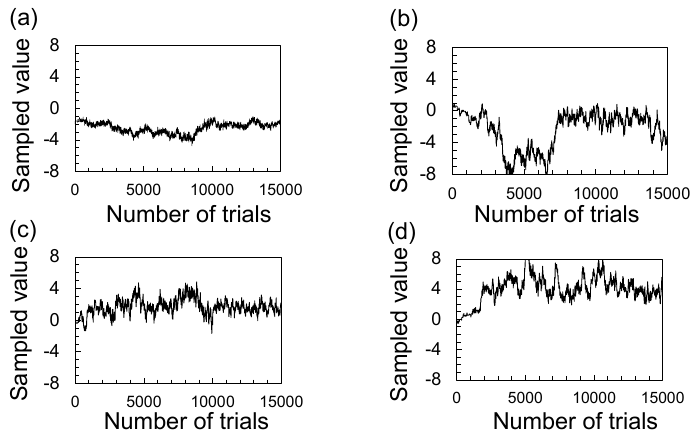
Figure 5. Trace plots of sampled values of parameters versus number of trials. ( a ) Common parameter (cid:2010) , and individual parameters: ( b ) (cid:2011) (cid:2869) , ( c ) (cid:2011) (cid:2870)(cid:2873) , and ( d ) (cid:2011) (cid:2871)(cid:2871) .